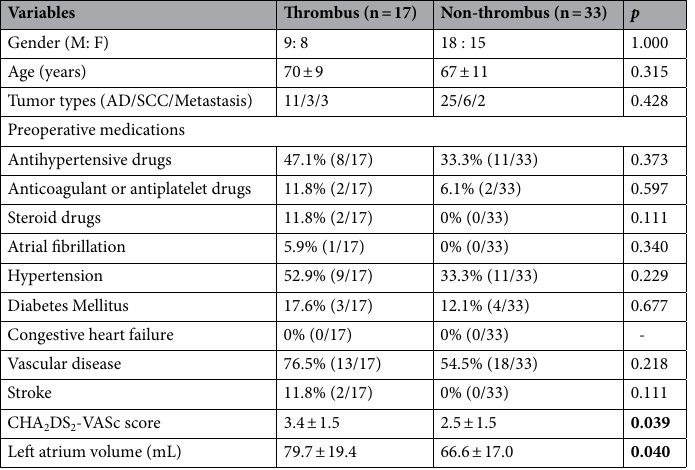
Table 1. Clinical characteristics according to PV stump thrombosis formation after left upper lobectomy. AD, adenocarcinoma; SCC, squamous cell carcinoma . Continuous values are presented as mean ± SD. Significant values are in